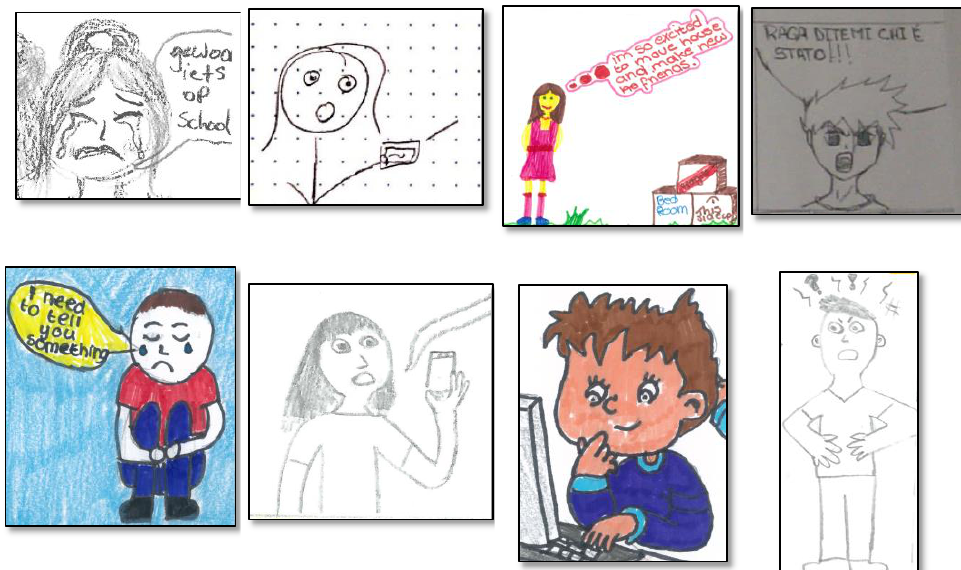
Figure 4. Examples of cybervictims’ emotions. From left to right in both rows, Sadness, Surprise, Joy, Anger. The phrase “Gewwon iets op school” means “Just something at school”; the sentence “Raga